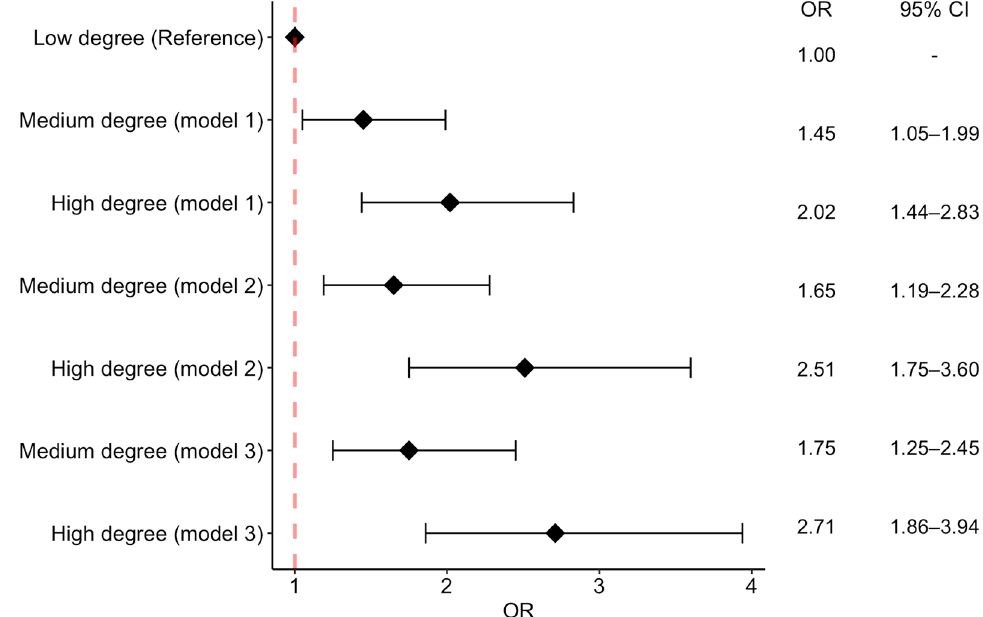
Figure 1. ORs between negative emotion degrees and COVID-19 vaccine acceptance. OR: odds ratio, CI: confidence interval. Model 1: Adjusting for demographic factors (including sex and age). Model 2: Adjusting for demographic and socioeconomic status factors (including education, employment status, and economic stress). Model 3: Adjusting for demographic and socioeconomic status factors, and other risk factors (including comorbidities, COVID-19 diagnosis, vaccination refusal in the past, and opinions about the government’s COVID-19 response).